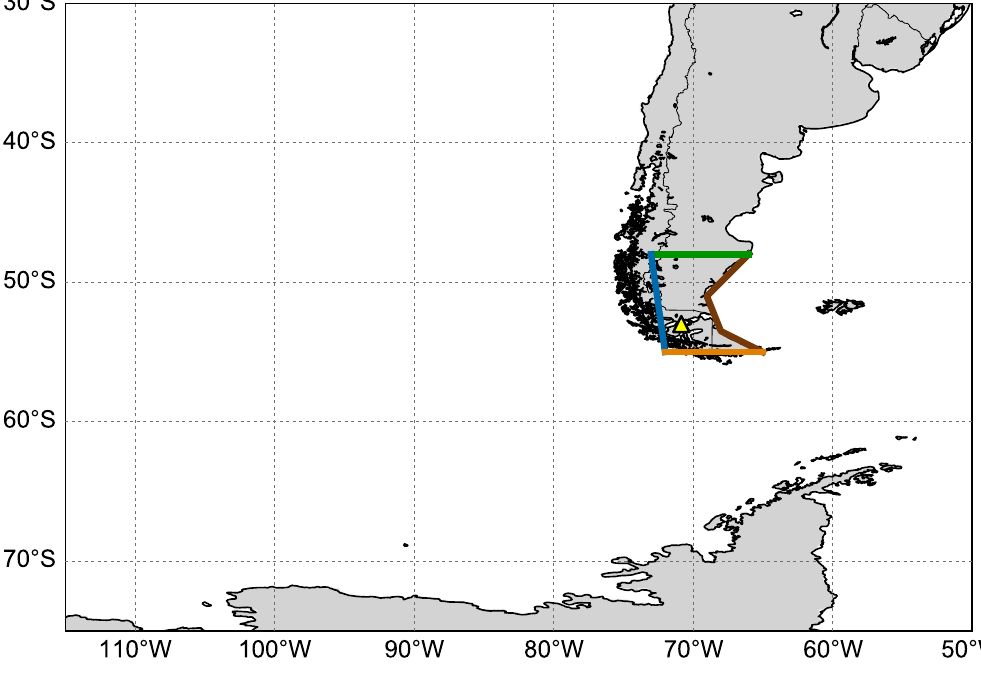
Figure A3. Map showing the delineations of eastern (brown), northern (green), western (blue), and southern (orange) moisture transport boundaries of Southern Patagonia landmass used in this study. If a back-trajectory came across one of the above boundaries, that trajectory was clustered into distal easterlies, northerlies, westerlies, and southerly trajectories, respectively. Here the western boundary of Southern Patagonia landmass is set on the east of the Andes so that any back-trajectory crossing over the Andes will be classified as the distal